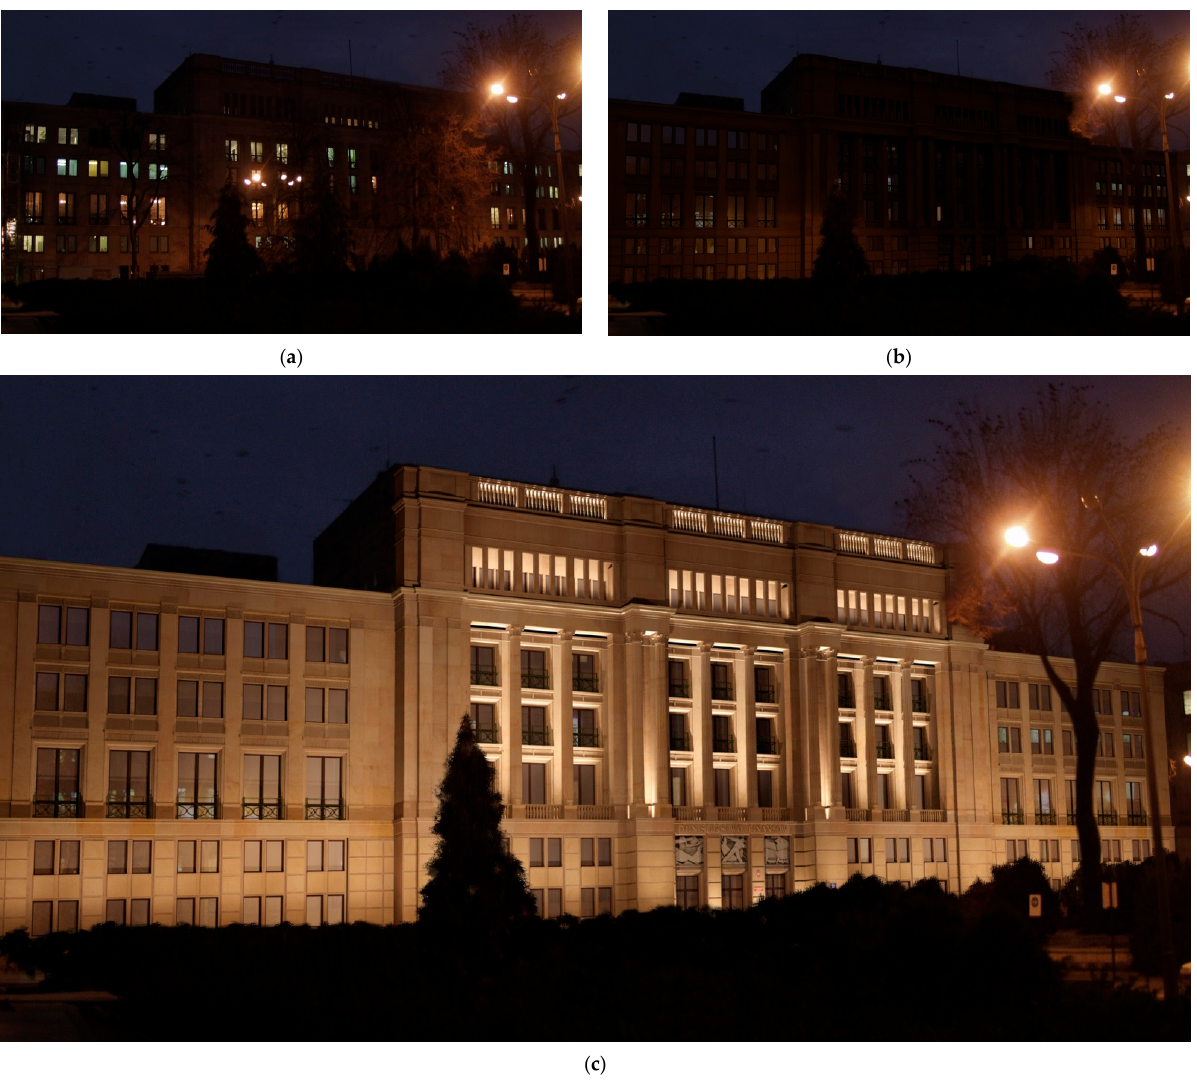
Figure 5. Stages of creating the collage of the rendering and the evening photograph of the object. ( a ) The evening photo of the object, ( b ) the object illuminated by the level of illuminance corresponding to the conditions under which the photograph was taken, ( c ) the final floodlighting design.